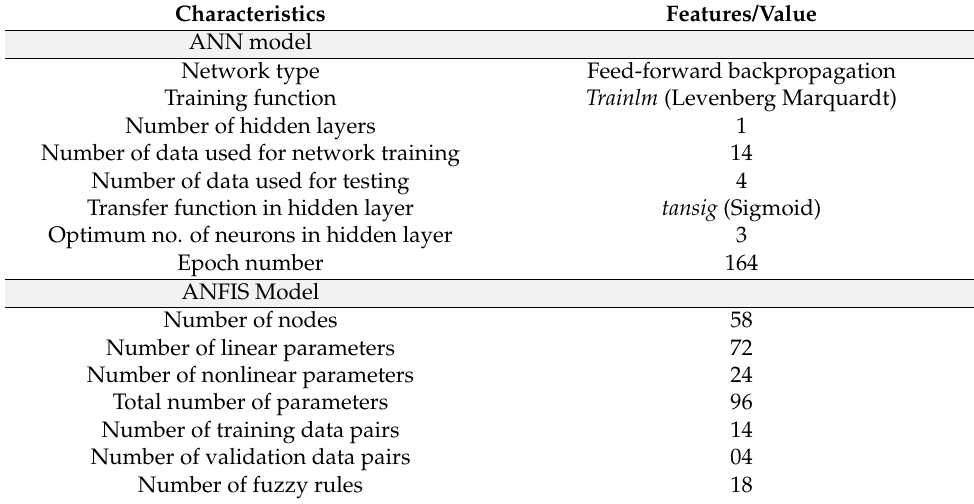
Table 3. The features of ANN and ANFIS structure used in